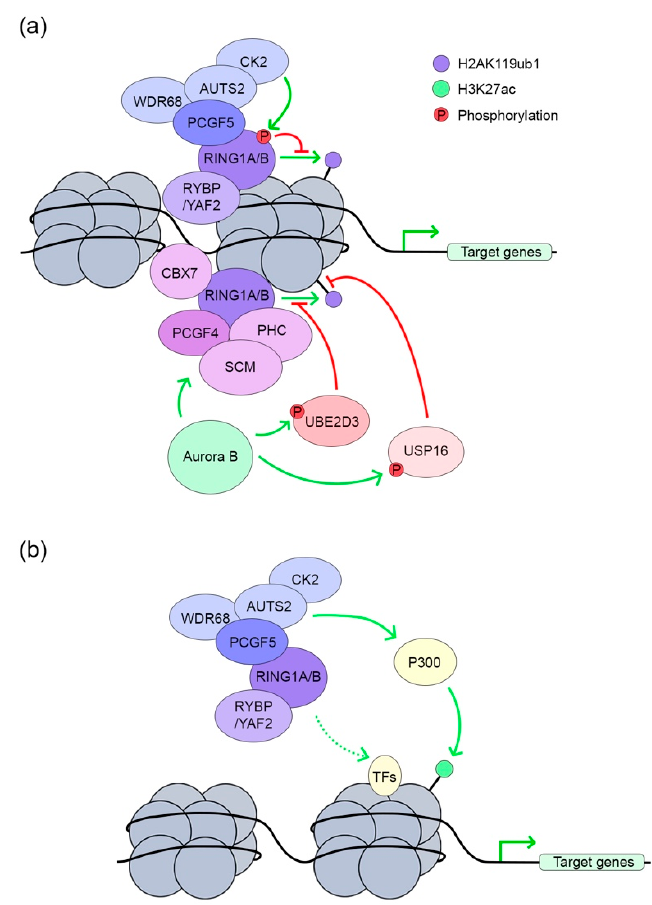
Figure 3. PRC1-mediated transcription activation. ( a ) Some PRC1-associated proteins directly or indirectly neutralize the H2AK119ub1 enzymatic activity of PRC1; ( b ) AUTS2-containing PRC1.3 / 5 is recruited by transcription factors and sequentially drives P300 to the same loci for acetylation of histone H3 at lysine 27 (H3K27ac).